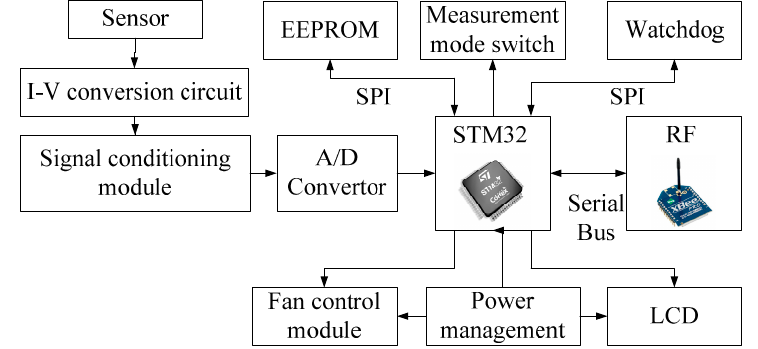
Figure 6. Diagram of the proposed wireless circuit.